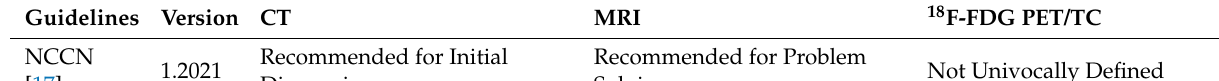
Table 1. NCCN, ESMO and AIOM guidelines for the use of CT, MRI and PET in